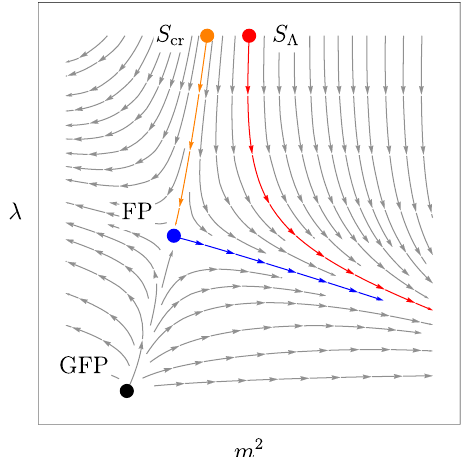
Figure 1. RG diagram illustrating the relation between the linear and nonlinear sigma models; the trajectories represent lines of constant physics at large scales. The couplings are a quartic self interaction of the linear model and a squared mass in units of the RG scale, and their RG system has a nontrivial fixed point (FP) that is distinguished from the Gaussian fixed point (GFP). The fixed point controls the infrared behavior of the linear sigma model, as can be seen from the red trajectory that spawns from the point S Λ that represents a given “bare” theory characterized by a microscopic scale a or an ultraviolet energy Λ ∼ a − 1 . The fixed point drives the red trajectory to some infrared limit, located on the right in this example, that is representative of a macroscopic phase (e.g., broken or unbroken symmetry). In statistical mechanical models, S Λ can be tuned to a critial value S cr (for example moving it towards the left in the picture), so that the trajectory would fall towards the fixed point itself following the orange trajectory and the theory becomes scale invariant by construction. The tuning is often achieved by changing the temperature to its critical value, T → T c , in the thermodynamical limit and under the assumption that the parameters of S Λ depend on T . The same fixed point, however, is seen as an ultraviolet one for the theories located on the blue trajectory, which represent the nonlinear sigma model. In the infrared limit the red and blue trajectories are taken to the same macroscopic phases, because they follow the same RG directions asymptotically, and thus belong to the same universality class. One important message is that the two models, linear vs. nonlinear, see the same fixed points in two rather different lights, infrared vs. ultraviolet, however it is perfectly legitimate to talk about the notion of universality class for both models. A useful remark for gravity is the following: an asymptotically safe trajectory for gravity would be the blue curve, since it is ultraviolet complete, while the rest of the RG diagram could represent any lattice-based attempt to find the continuum limit of gravity based on some lattice scale a ∼ Λ − 1 (e.g., any approach based on Regge’s discretization [26,27], such as EDT or CDT [28,29]), in which case the ultraviolet critical point for quantum gravity is seen as a standard fixed point associated to a second order phase transition in the lattice (see also the appropriate discussion on Section